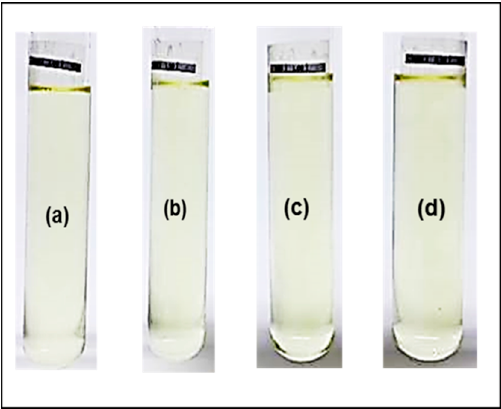
Figure 4. The appearance of gasoline-biodiesel blended fuels (GB) with biodiesel concentrations of